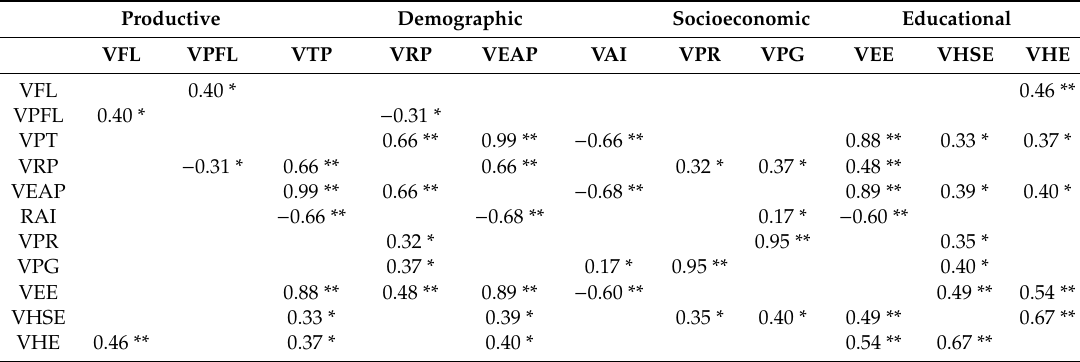
Table 2. Pearson correlation